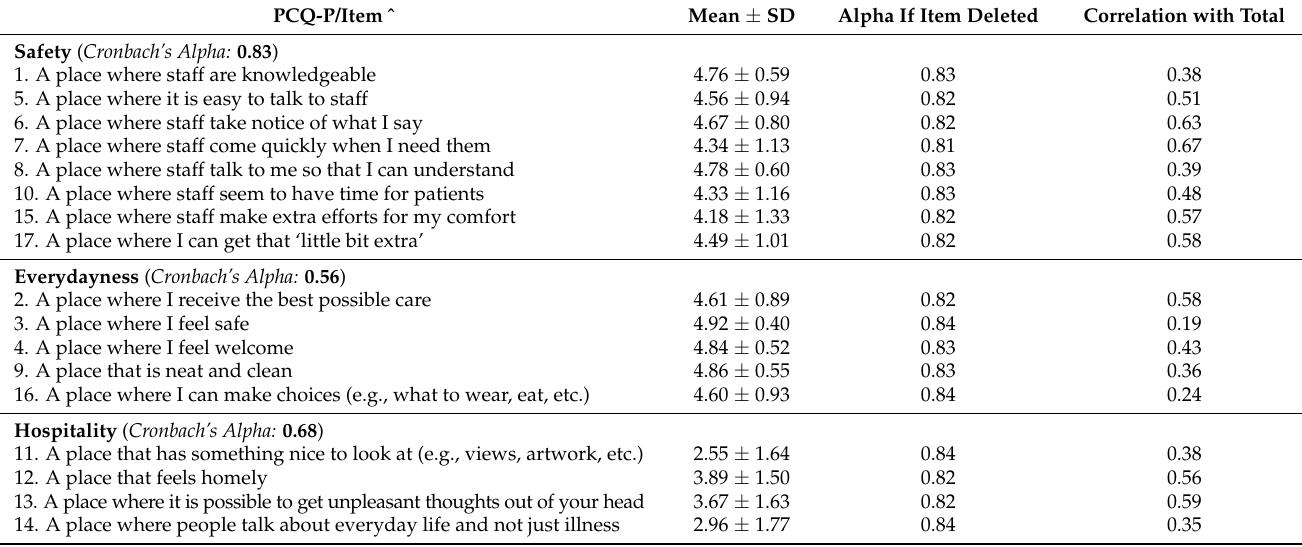
Table 2. Item performance and reliability estimates of the PCQ-P ( n =